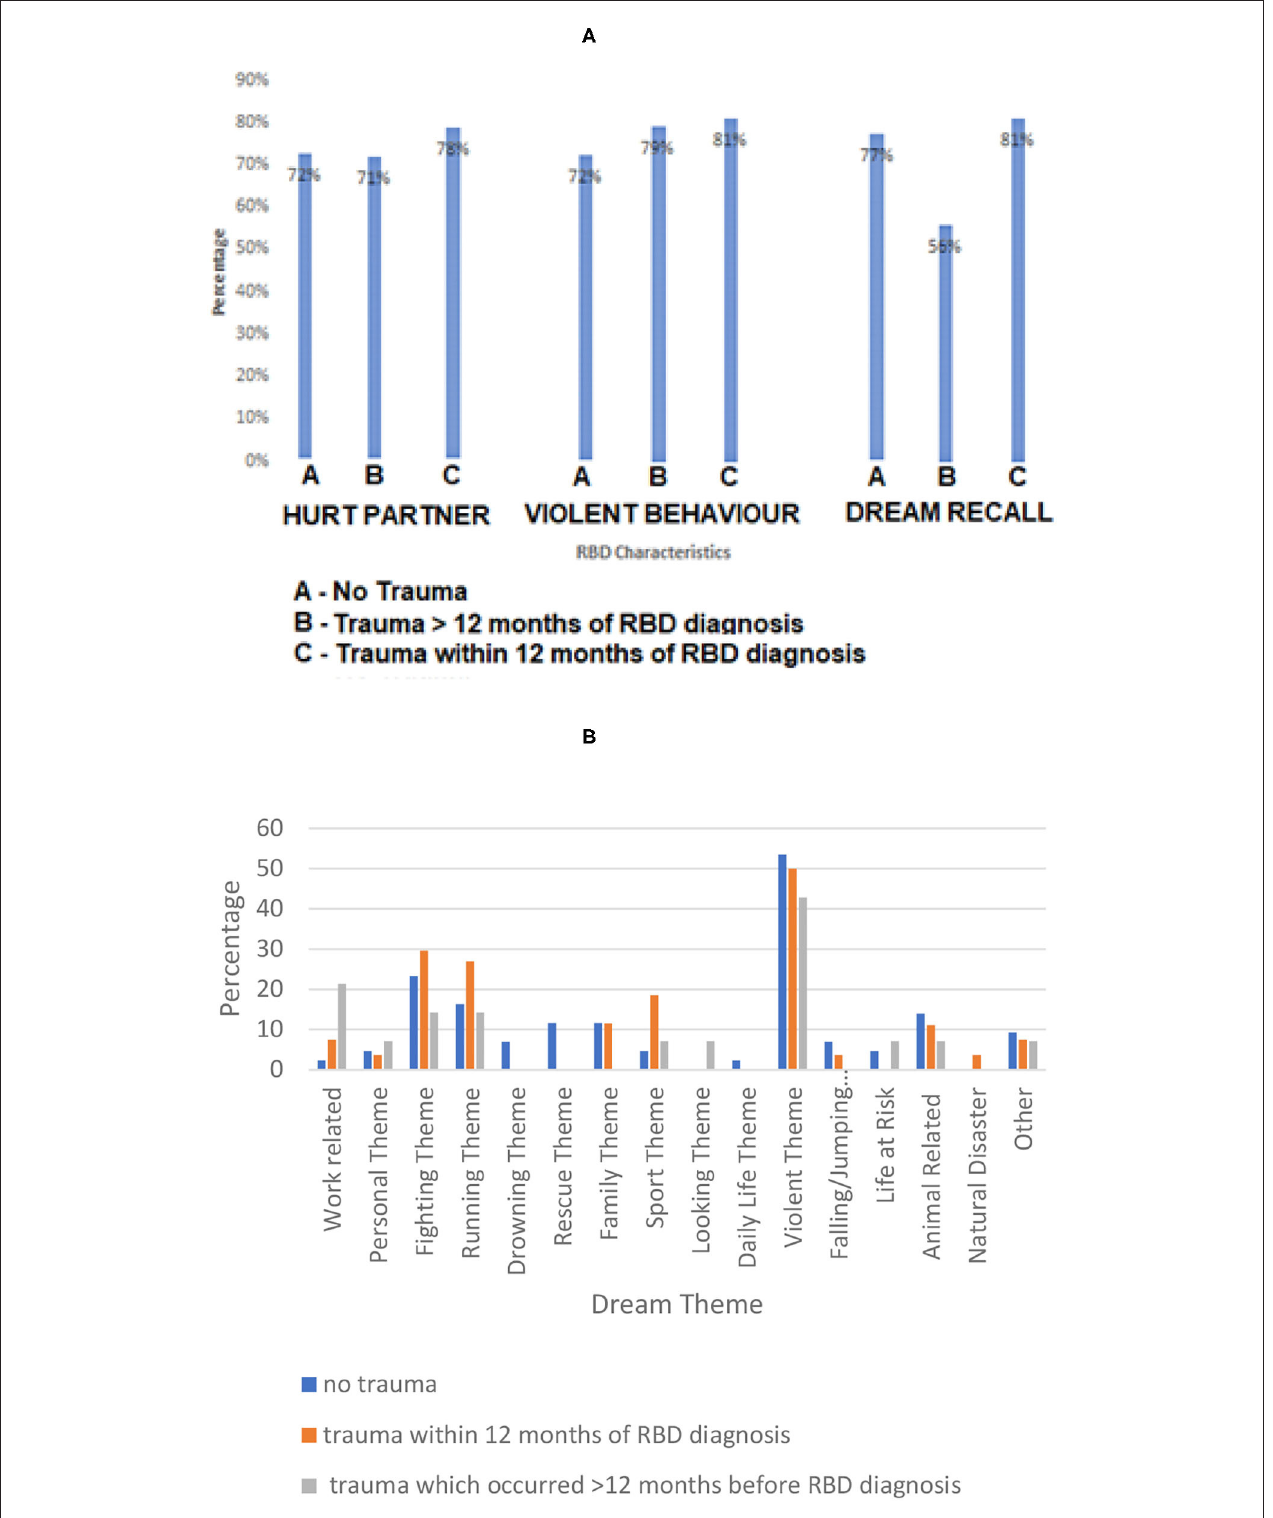
FIGURE 1 | RBD characteristics (A) and dream themes (B) across groups. (A) RBD characteristics for RBD patients with no trauma history (Group 1); trauma which occurred within 12 months of RBD diagnosis (Group 3); trauma which occurred > 12 months before RBD diagnosis (Group 2). Percentage of patients is relative to trauma group for (A,B) . No significant difference between groups was found in the reported dream recall, incidence of violent nocturnal behavior or incidence in